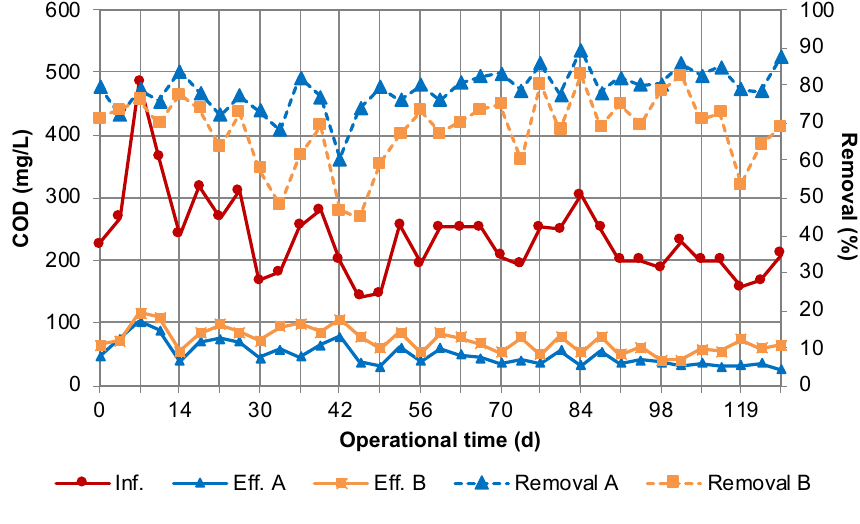
Fig. 5 Profile of COD removal for SBR A and SBR B over the experimental